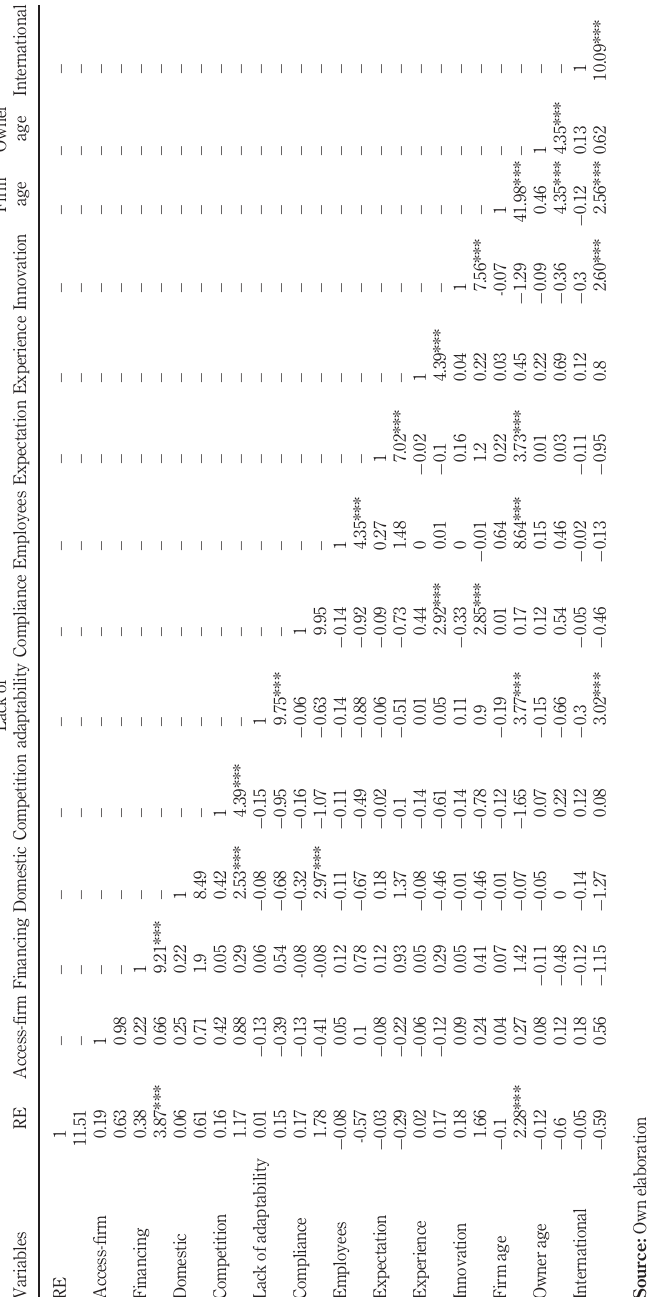
Table 5. Correlation